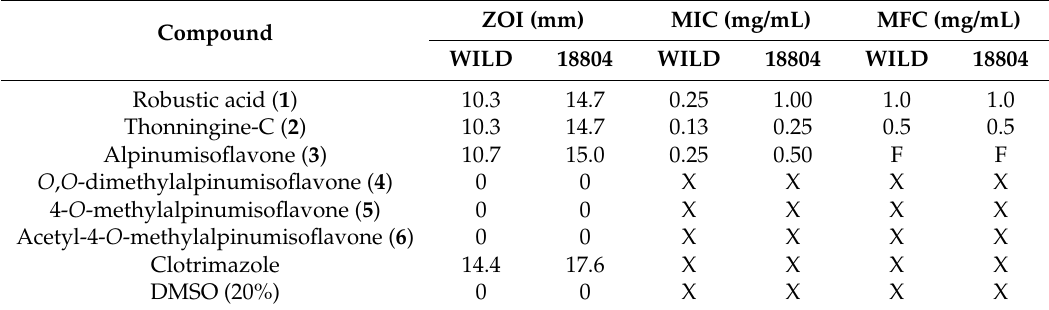
Table 2. Zones of inhibition (ZOI), minimum inhibitory concentrations (MIC) and minimum fungicidal concentrations (MFC). ZOI (mm) MIC (mg/mL) MFC (mg/mL) Compound WILD 18804 WILD 18804 WILD 18804 Robustic acid ( 1 ) 10.3 Thonningine-C ( 2 )